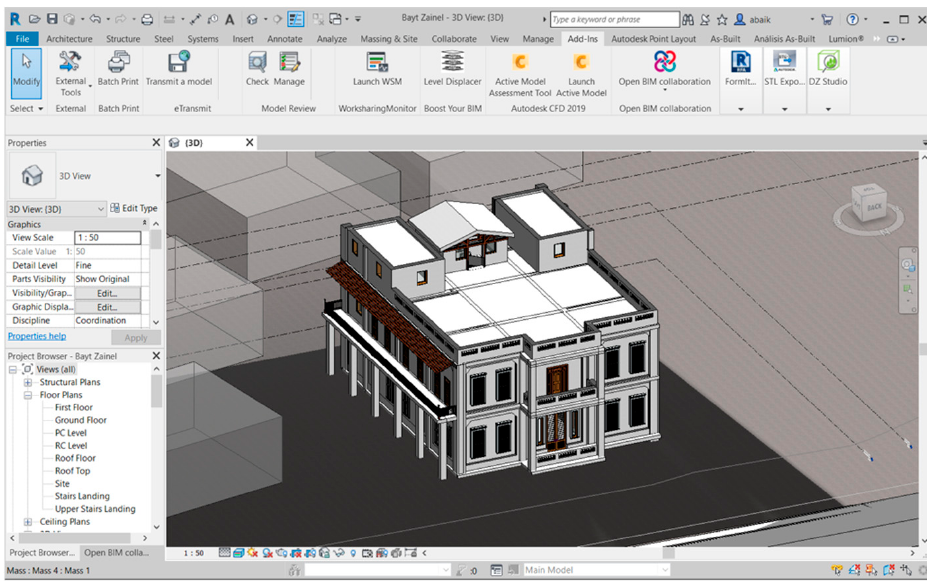
Figure 14. Exporting the 3D BIM model in IFC format.